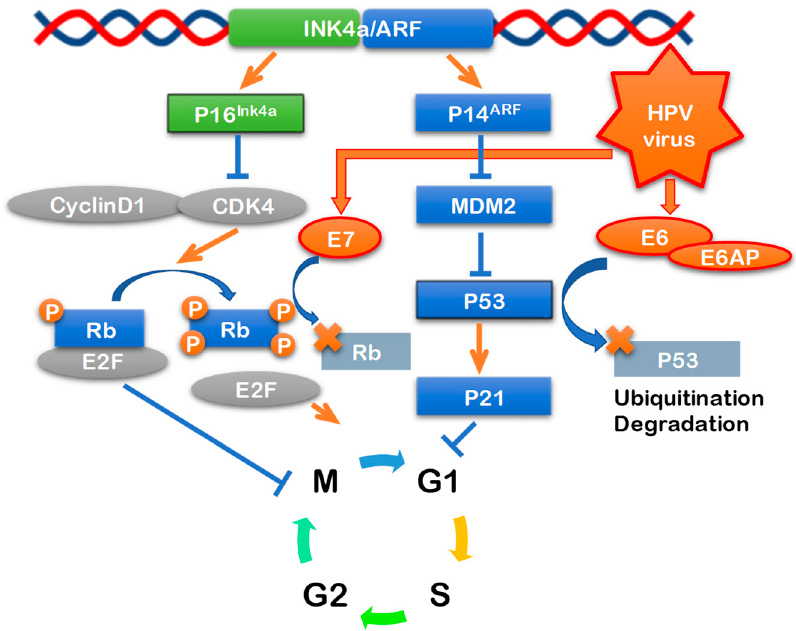
Figure 1. Signaling pathways of high-risk HPV oncogenes. High-risk HPVs encodes two known viral oncogenes. E6 protein inactivates tumor suppressor p53 mediated DNA damage and apoptosis pathway. E7 protein inactivates tumor suppressor pRb mediated cell cycle regulation pathway.